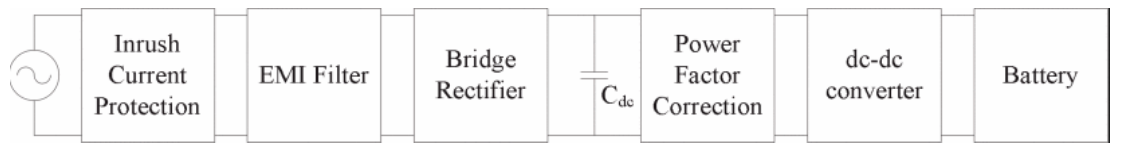
Figure 4. EV charging structure overview [26].